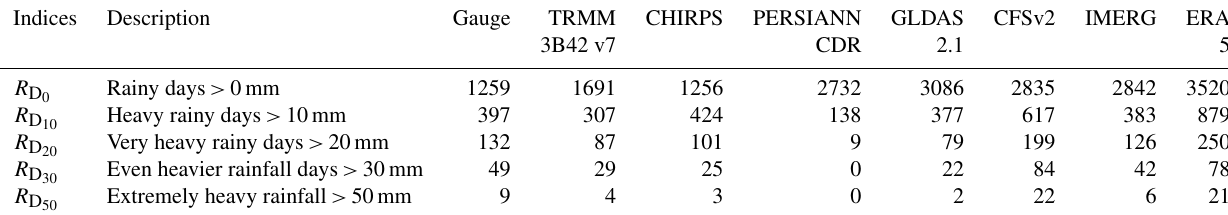
Table 3. Performance of satellite precipitation products based on rainfall frequency indicators.